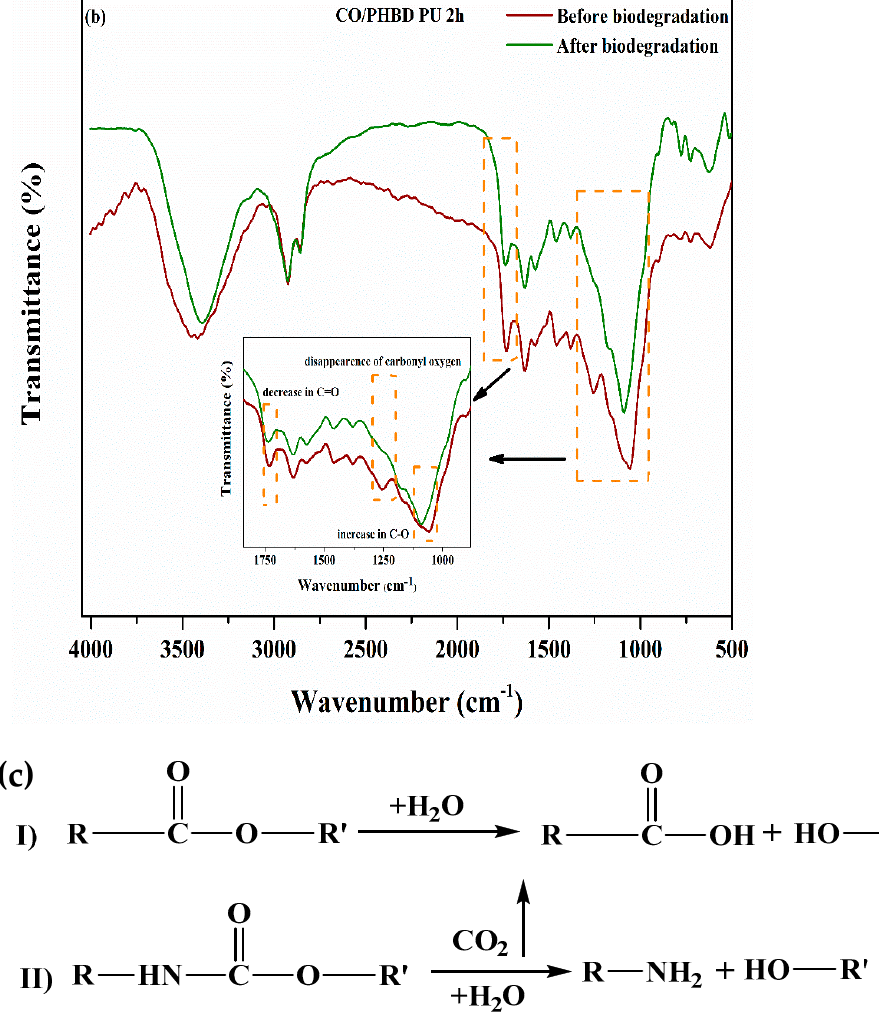
Figure 10. (a ) Residual weight with time, ( b ) FTIR analysis of CO/PHBD PU after soil biodegradation (after 35 days), and ( c ) a possible mechanism for the biodegradation process of CO/PHBD PU.